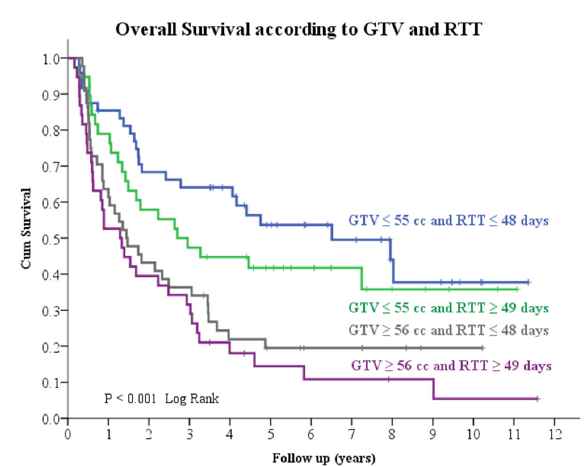
Fig. 1. Univariate Kaplan-Meier Analysis proved significantly better local control with gross tumour volume ≤ 55 cc and ra- diotherapy treatment time ≤ 48 days.